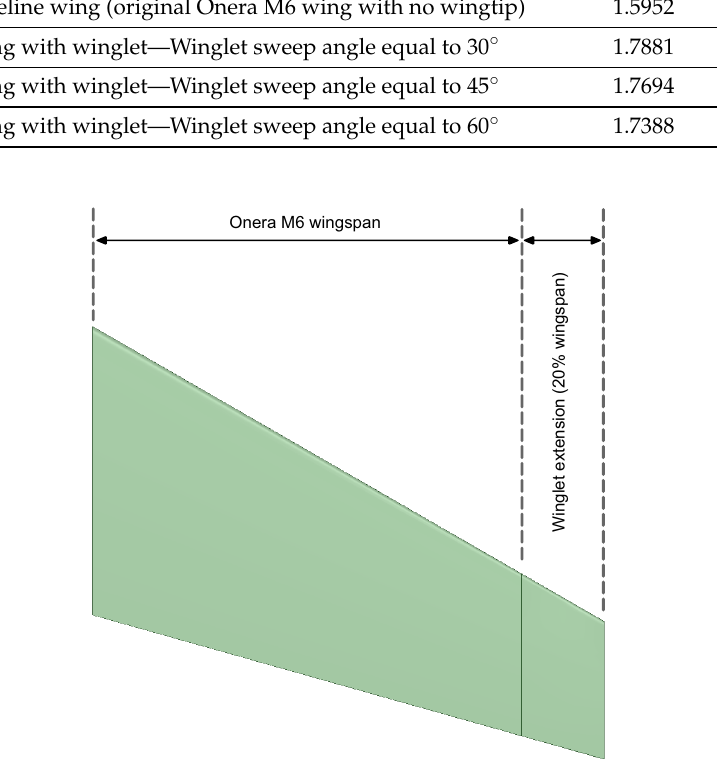
Figure 6. Wing and winglet extension. The winglet span used in this study corresponds to a 20% of the wing span of the original Onera M6 wing.